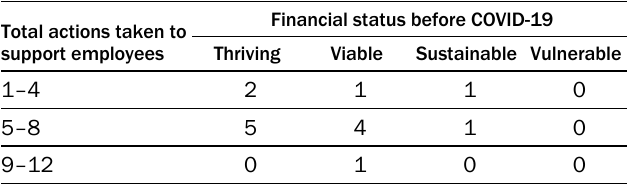
Table 6. Financial Status Before COVID-19 and